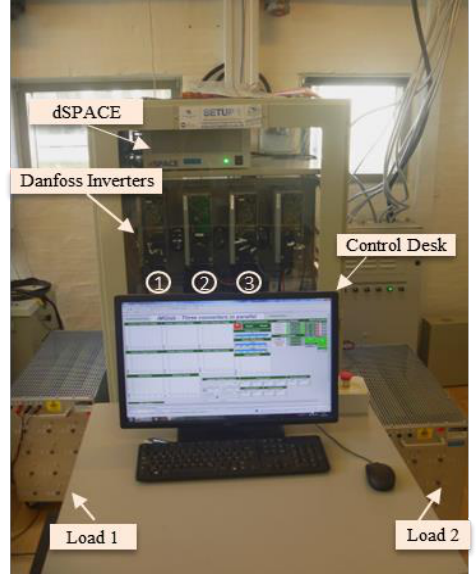
Figure 11. Experimental setup.